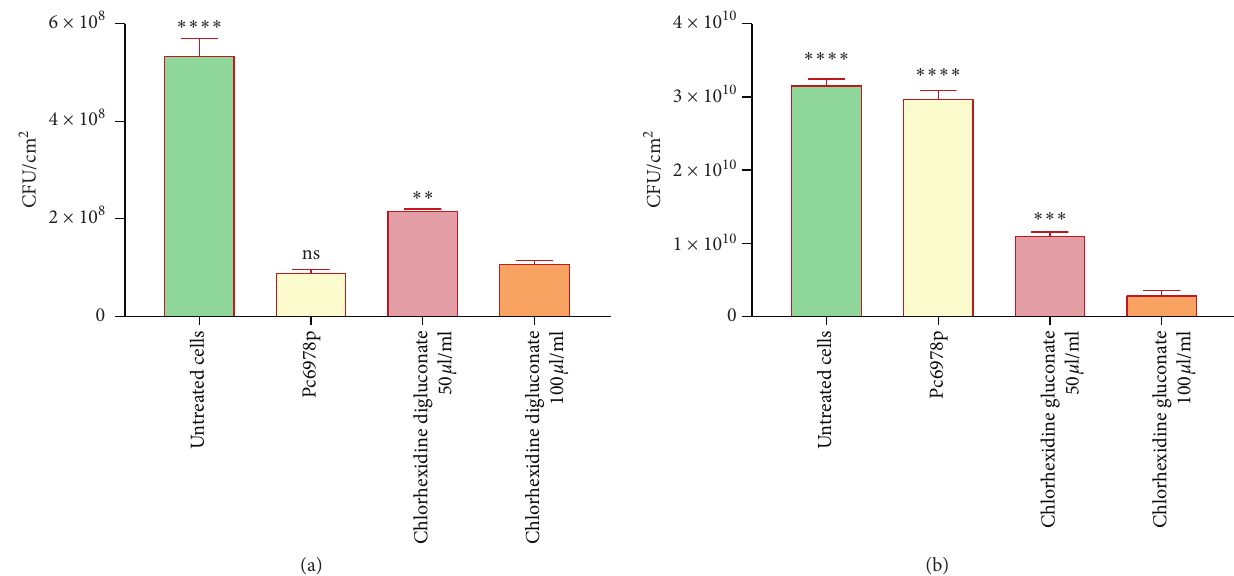
Figure 10: Biocidal effects of compound Pc6978p at a concentration of 100 µ g/mL on C. krusei cells (a) and M. smegmatis cells (b) after incubation for 30minutes at 37 ° C. Untreated cells are the positive control of growth of cells; no biocide was added to the cell. Chlorhexidine digluconate 50 µ g/mL and 100 µ g/mL are the standard positive control of a biocide. Error bars represent the standard deviation of 2 individual replicates. The asterisk ( ∗ ) indicates the significant difference from the positive control chlorhexidine 100 µ g/mL using statistical one-way ANOVA (where ∗ P < 0 . 05, ∗ ∗ P < 0 . 01, ∗ ∗ ∗ P < 0 . 001, ∗ ∗ ∗ ∗ P < 0 . 0001, and “ns” means no significant